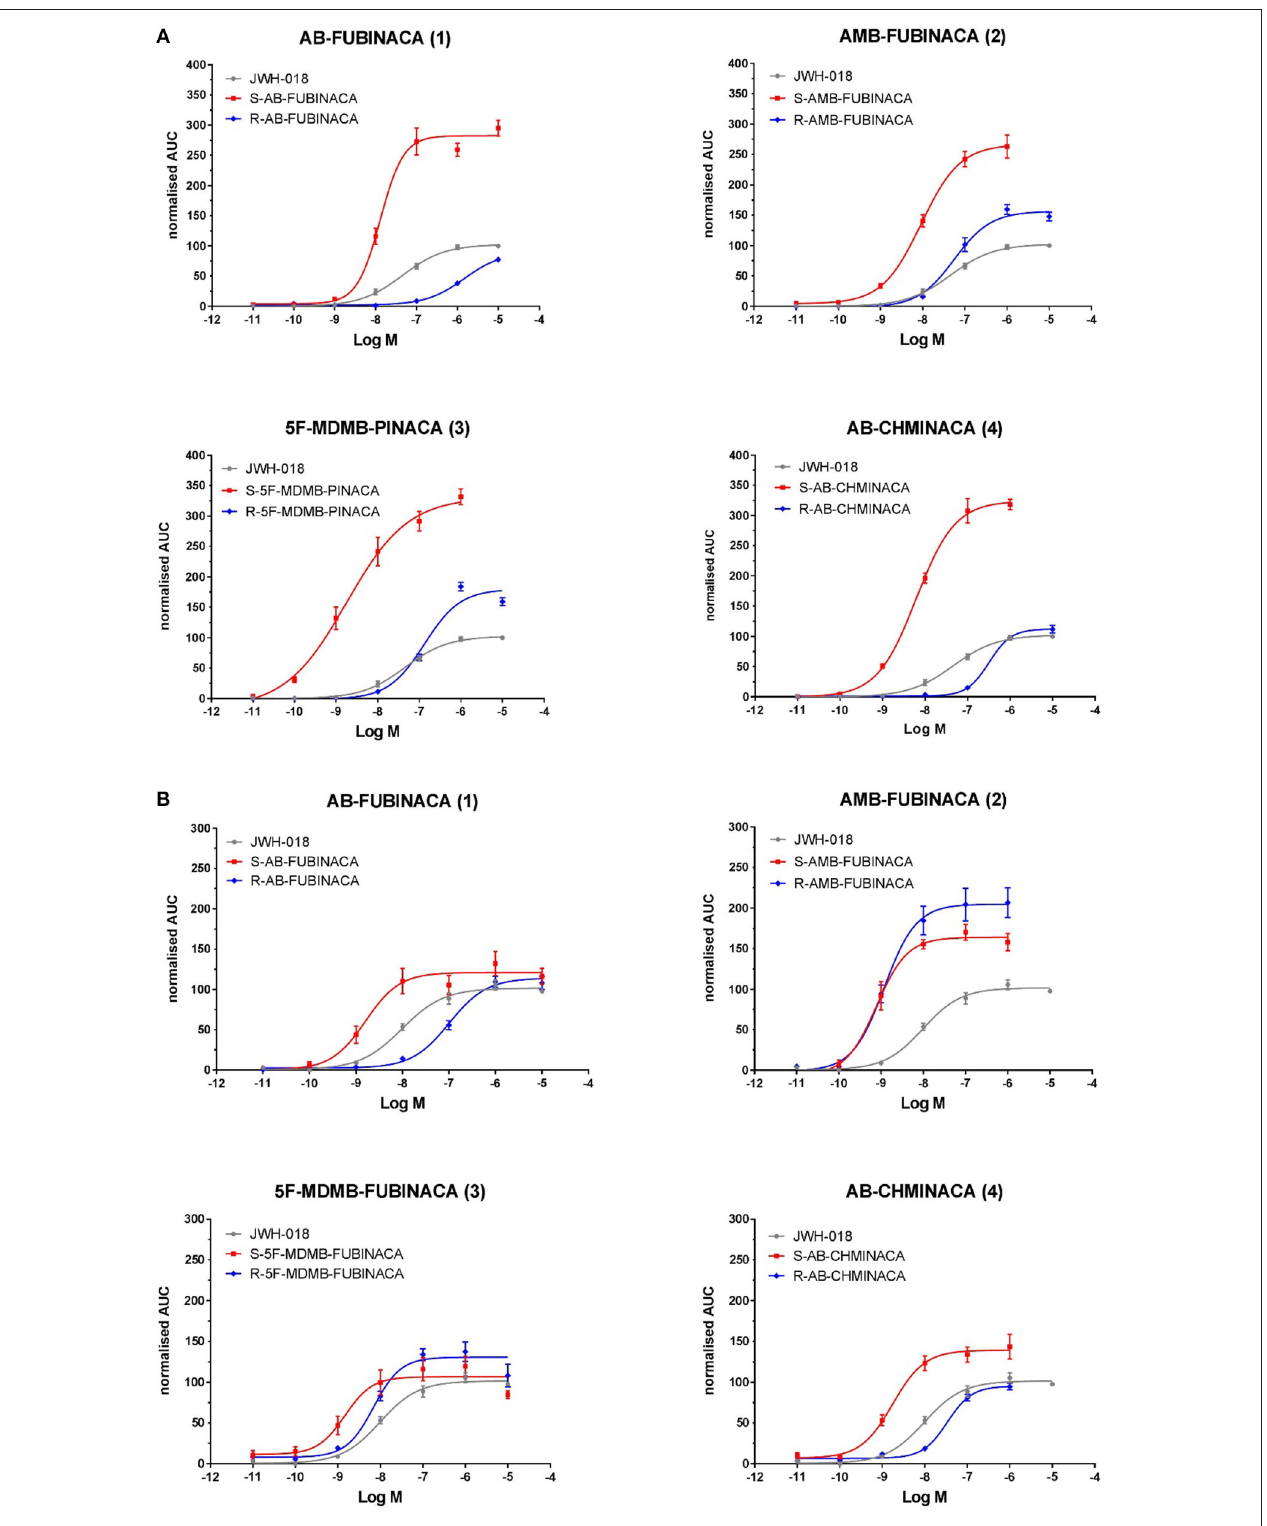
FIGURE 3 | EC 50 curves of indazole-3-carboxamide synthetic cannabinoids for (A) CB 1 and (B) CB 2 receptors. Each data point represents the mean value and error bars represent the standard error of the mean (SEM) for at least seven replicates (obtained in 3 independent experiments). Compound numbering relates to that provided in Figure 1